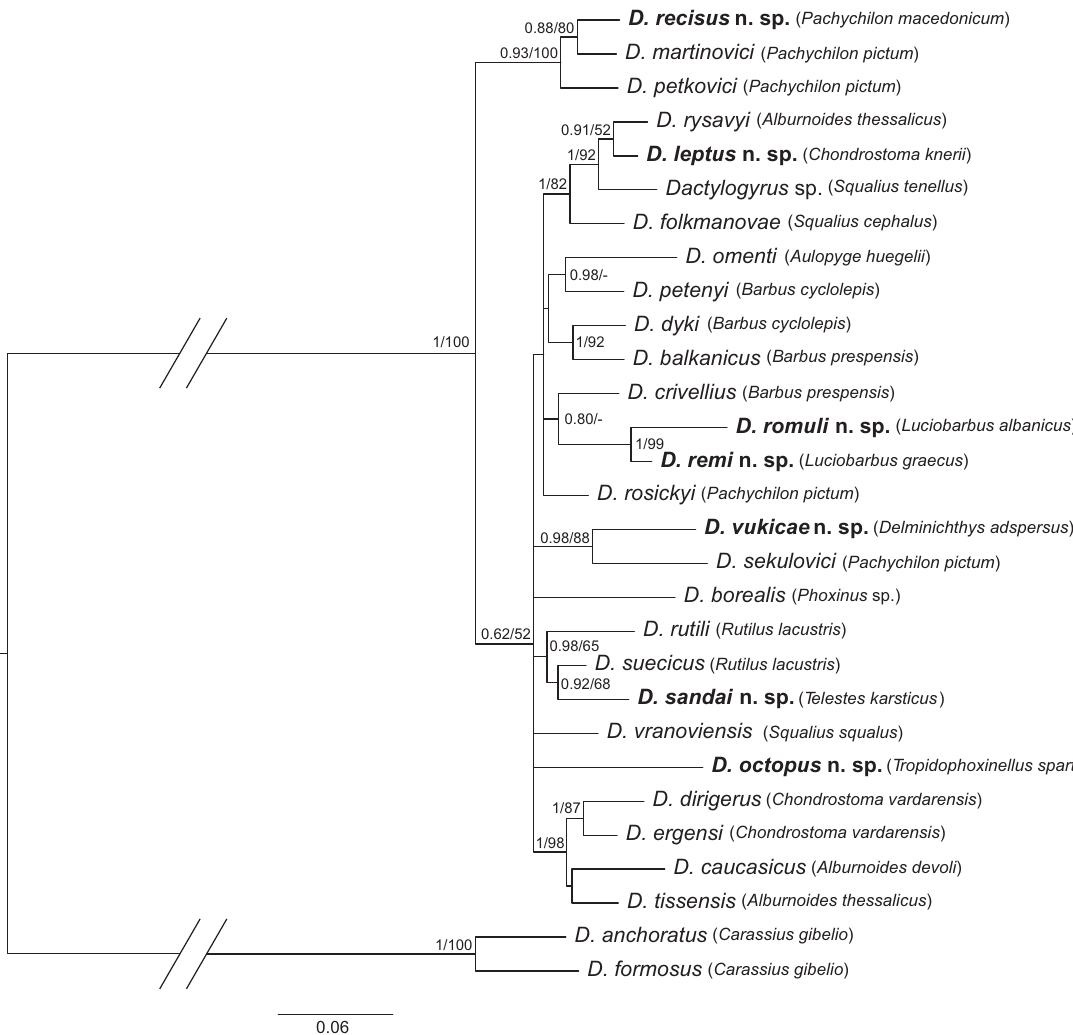
Figure 14. Phylogenetic tree of 29 Dactylogyrus species (hosts in brackets) constructed by Bayesian Inference (BI). The tree is based on the combined DNA sequences of partial genes coding 18S rRNA, 5.8S rDNA, 28S rRNA and the entire ITS1 region. Values along branches indicate posterior probabilities and bootstrap values for each node resulting from Bayesian Inference and Maximum likelihood (ML) analyses, respectively. Values <0.80 for BI and <50% for ML are indicated by